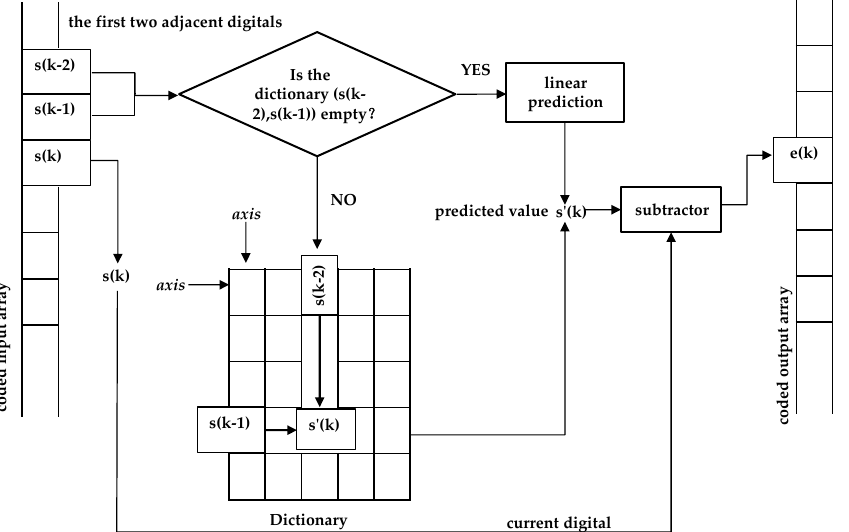
Figure 2. Principle block diagram of the coding algorithm.